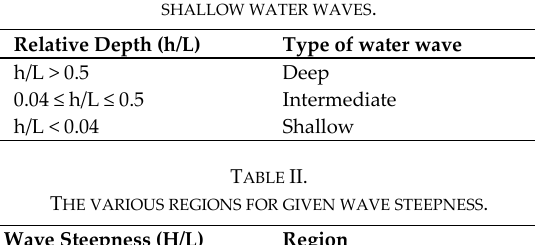
Figure 1. Definition of wave motion ( 𝐿 - wavelength, 𝐻 - wave height, ℎ - water depth, 𝜂 - surface elevation, 𝑎 – wave